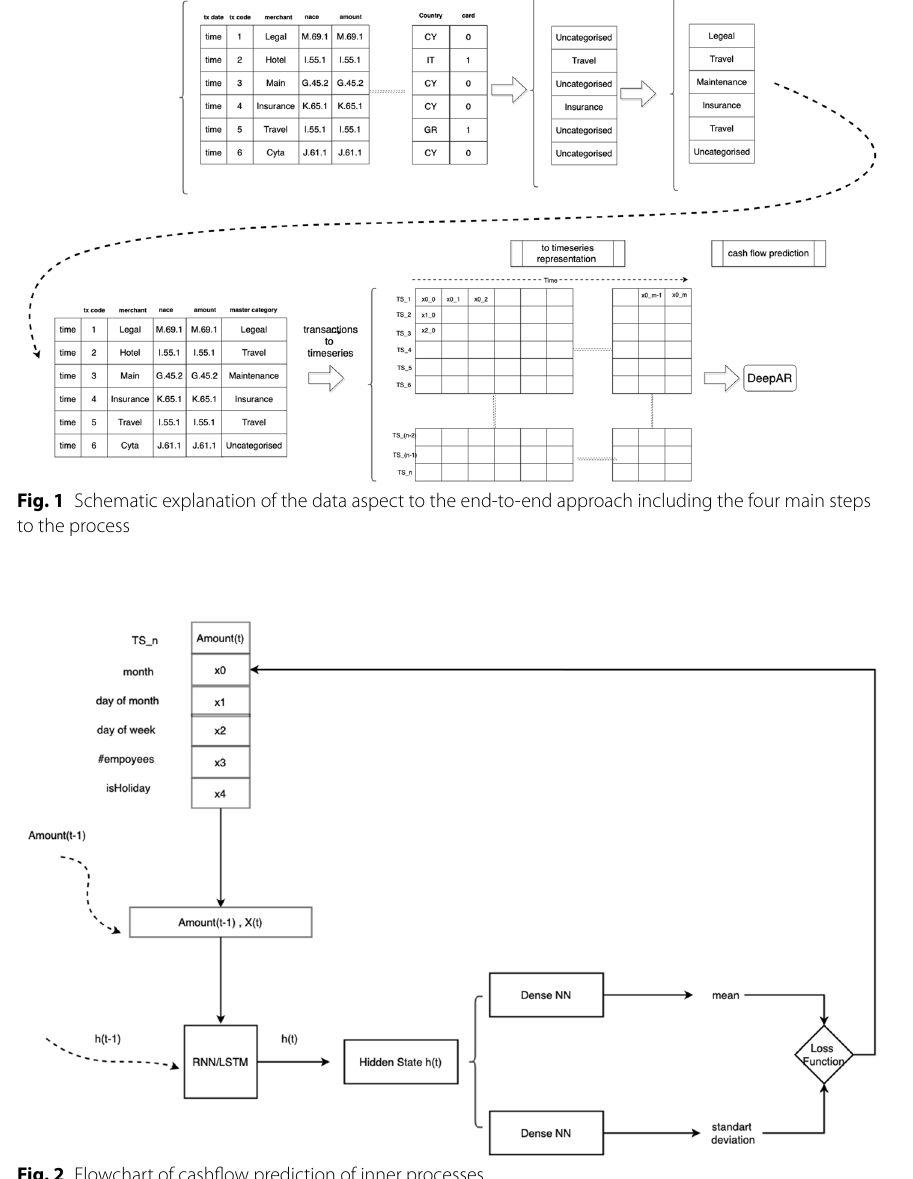
Fig. 2 Flowchart of cashflow prediction of inner